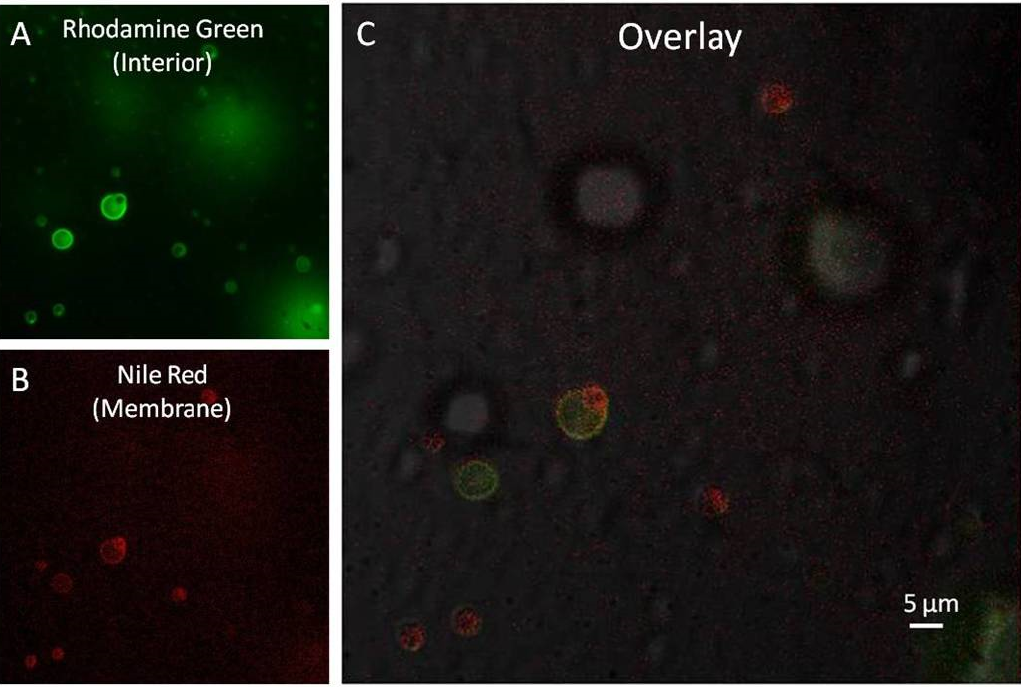
Figure 8. Confocal fluorescence microscopy demonstrating the entrapment capability of the CaCO 3 -coated liposomes. Rhodamine 110 and Nile Red dyes were used as model hydrophilic and hydrophobic entrapment agents, respectively. ( A ) Rhodamine 110 is a hydrophilic fluorescent dye that would be expected to reside in the water interior of the microcapsule. The bright ring around the particles suggests that some of the dye may also bind to the charged headgroup of the liposome or be incorporated into the shell during the PILP process. ( B ) Nile Red is a hydrophobic fluorescent dye that would be expected to reside in the hydrophobic region containing the hydrocarbon tail-groups of the phospholipid bilayer. ( C ) An overlay of A and B shows that the liposome-based microcapsule system displays versatility in the types of encapsulated agents that can be incorporated.